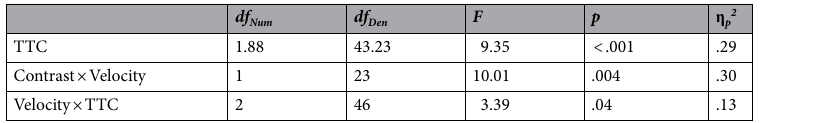
Table 2. Significant main and interaction effects of type 3 F -tests on mean variable errors ( SD ). p -values and degrees of freedom in the table incorporate Huynh–Feldt correction if appropriate. df Num = numerator degrees of freedom. df Den = denominator degrees of freedom. η p 2 = partial eta-squared.